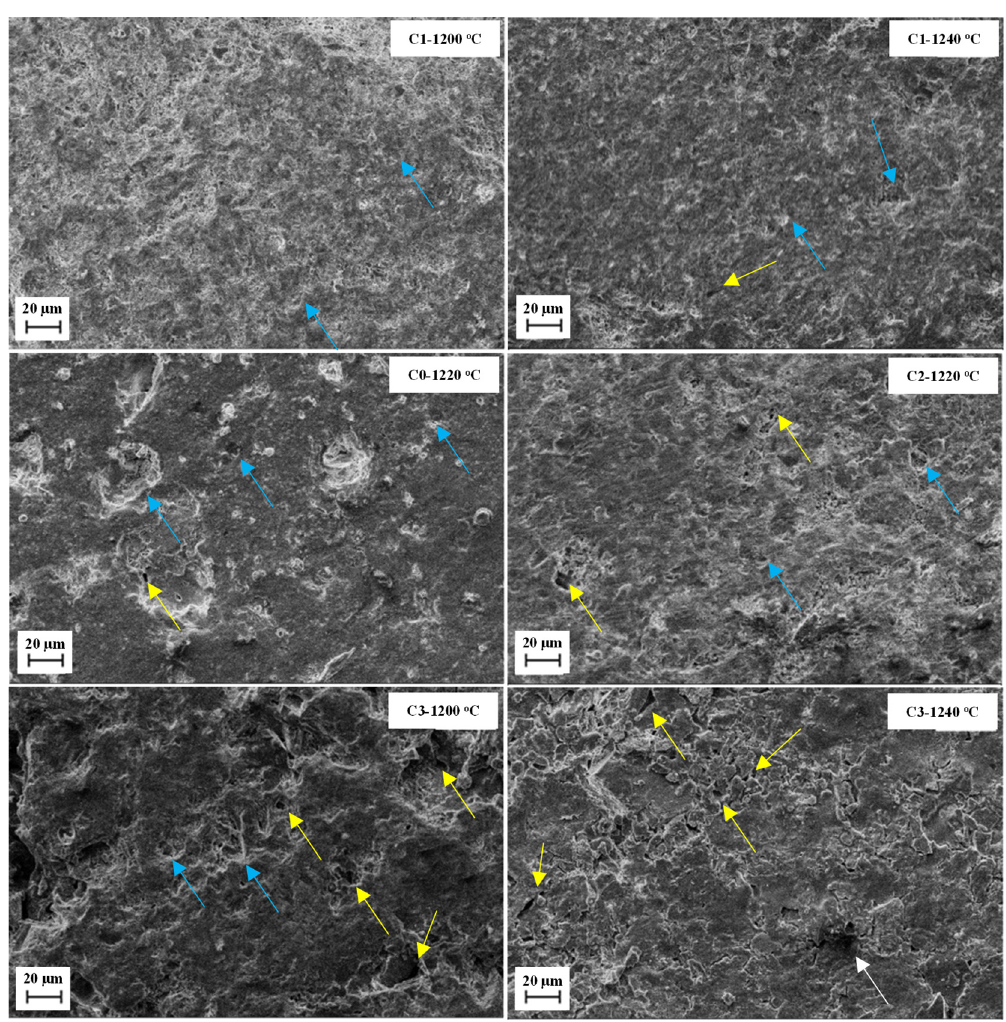
Figure 10. Micrographs (SEM) of studied compositions with specimens fractured after firing. Yellow arrows indicate open pores and blue arrows indicate closed pores.